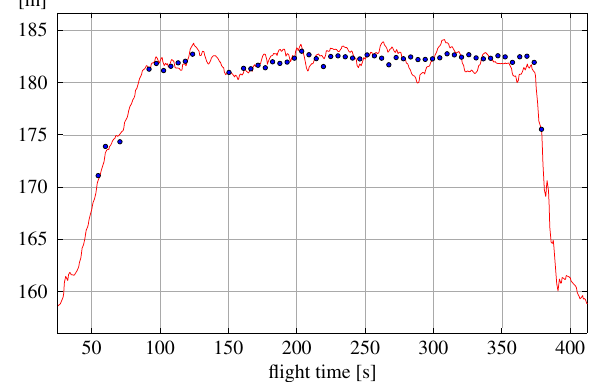
Figure 9: Comparison of direct and indirect georeferencing for the z-coordinate. The red line represents the direct georeferenc- ing result, whereas the blue dots correspond to the indirect geo- referencing.